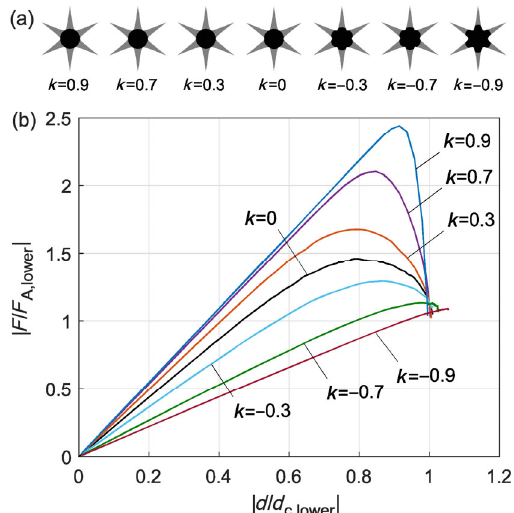
Fig. 16 Detachment of a flat-ended stamp with cross-section in form of a star from gradient media with various power k . (a) The last stable configuration for different    1 1 k . (b) The force- displacement dependencies show that the media with positive power k develop a much more pronounced pre-detachment leading to a maximum of force, while the media with large negative powers tend to a “brittle” detachment almost without pre-detachment. In the limiting case   1 k the force-displacement dependence degenerates into a linear dependency up to the point where the contact suddenly is